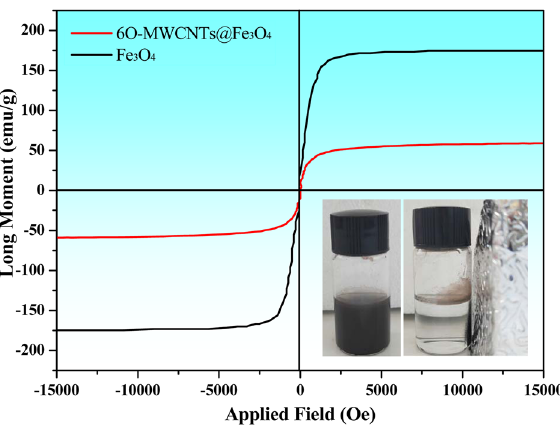
Figure 2. Changes in the hysteresis loop of 6O-MWCNTs loaded with magnetic